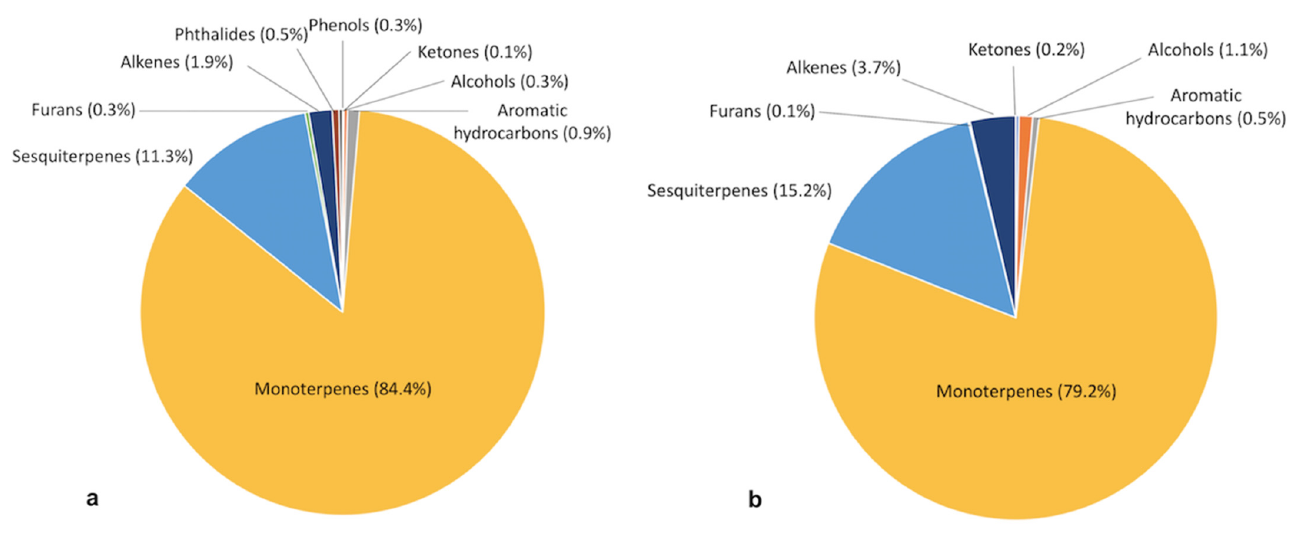
Figure 6. Distribution (%) of chemical groups of volatile compounds in celery stalk ( a ) and root ( b ). The main contributors to the characteristic citrus and herbal aroma of celery are ter- penoids [6,8,9], sesquiterpenes made up of three isoprene units (C 15 H 24 ) and monoter- penes with two isoprene units (C 10 H 16 ), which agrees with the results obtained in the pre- sent study. Table 3 shows the variation in percentage composition between the main vol-